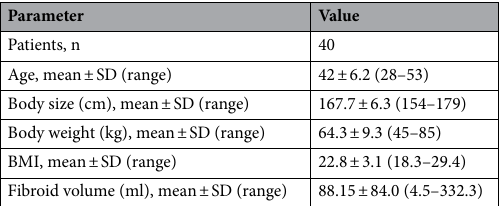
Table 1. Patients’ characteristics of 40 patients with symptomatic uterine fibroids (UF) treated with US-guided HIFU at our